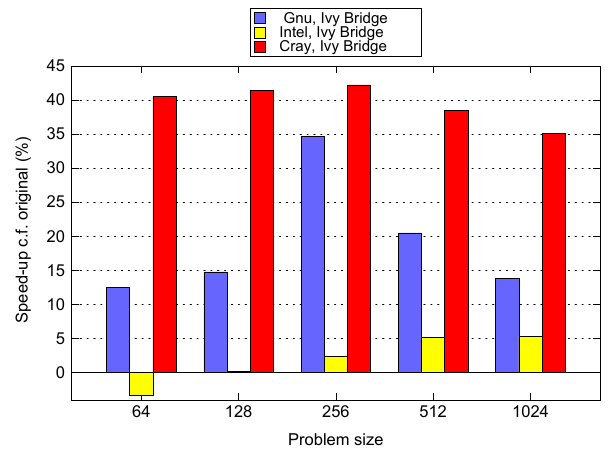
Figure 4. Comparison of the performance of the best PSyKAl ver- sion with that of the original version of the code. A negative value indicates that the PSyKAl version is slower than the original.